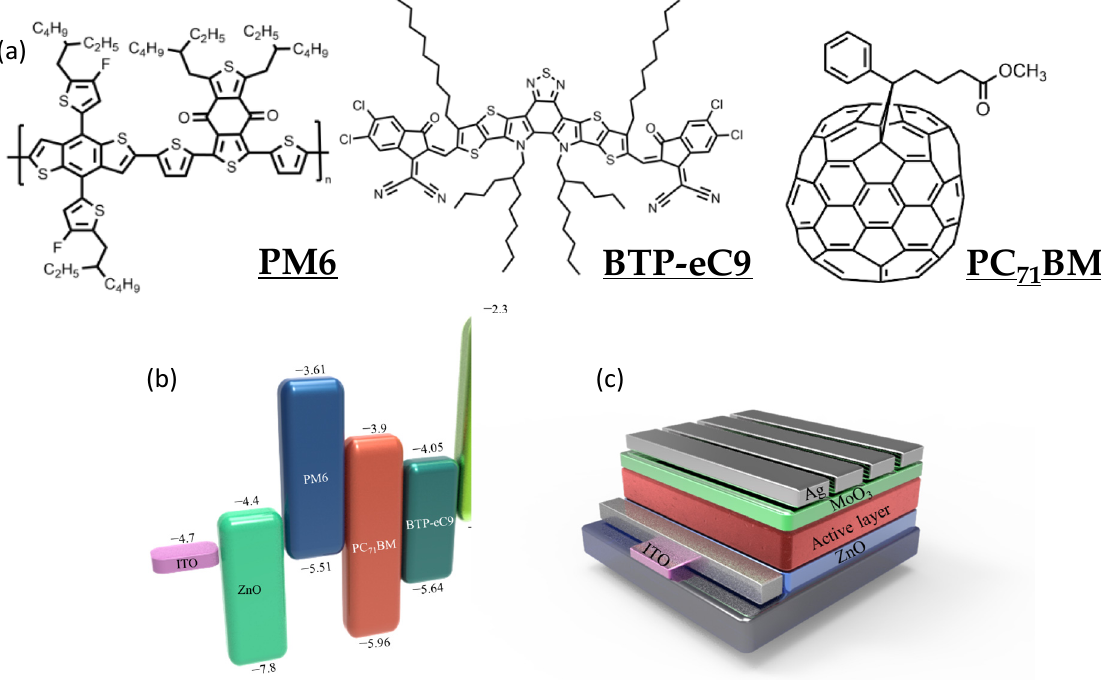
Figure 1. ( a ) Chemical structures and ( b ) energy levels of the materials used to prepare the OPDs. ( c ) Structure of the OPDs.